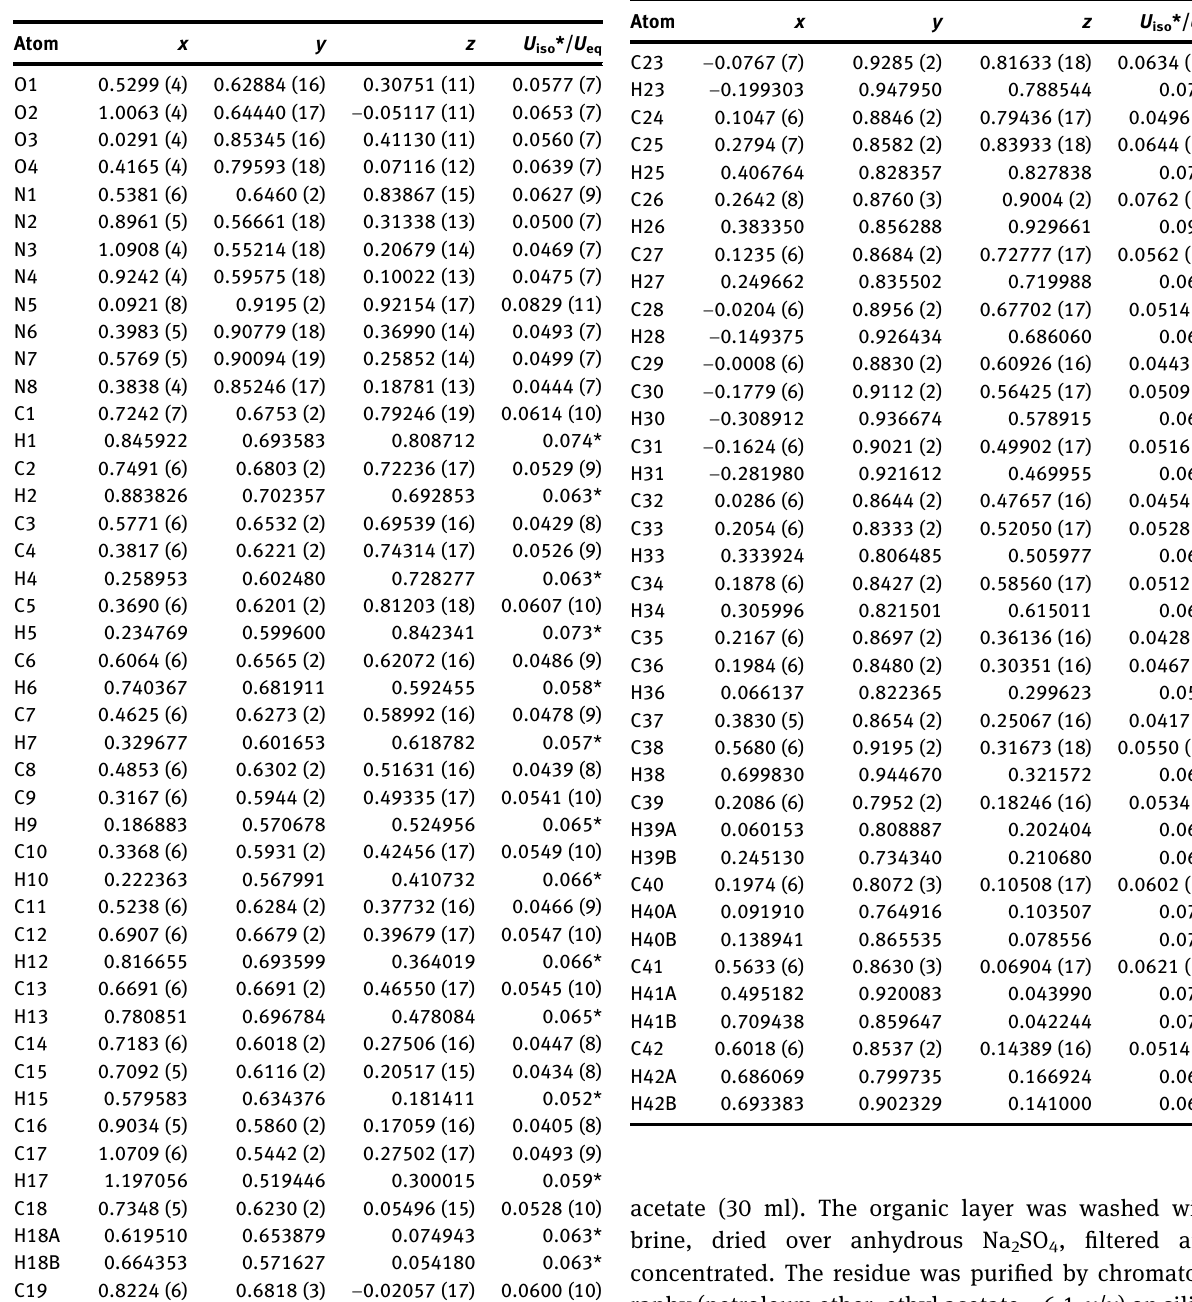
Table  : Fractional atomic coordinates and isotropic or equivalent isotropic displacement parameters (Å 